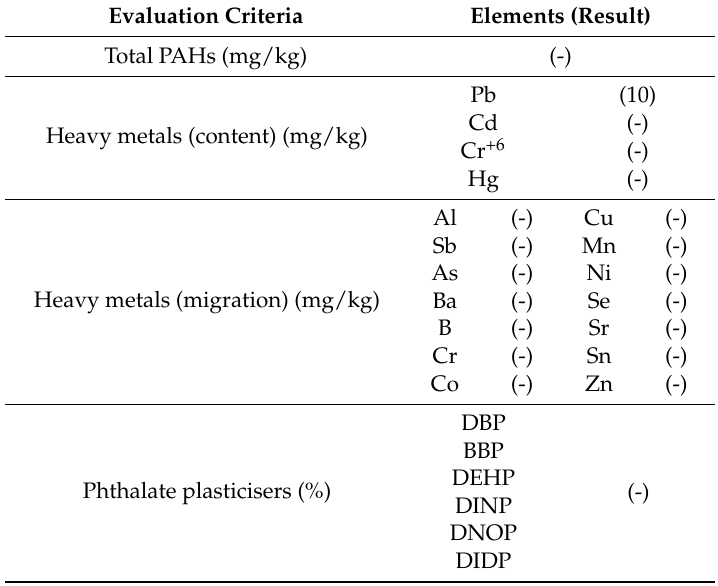
Table 4. Heavy metals test result.